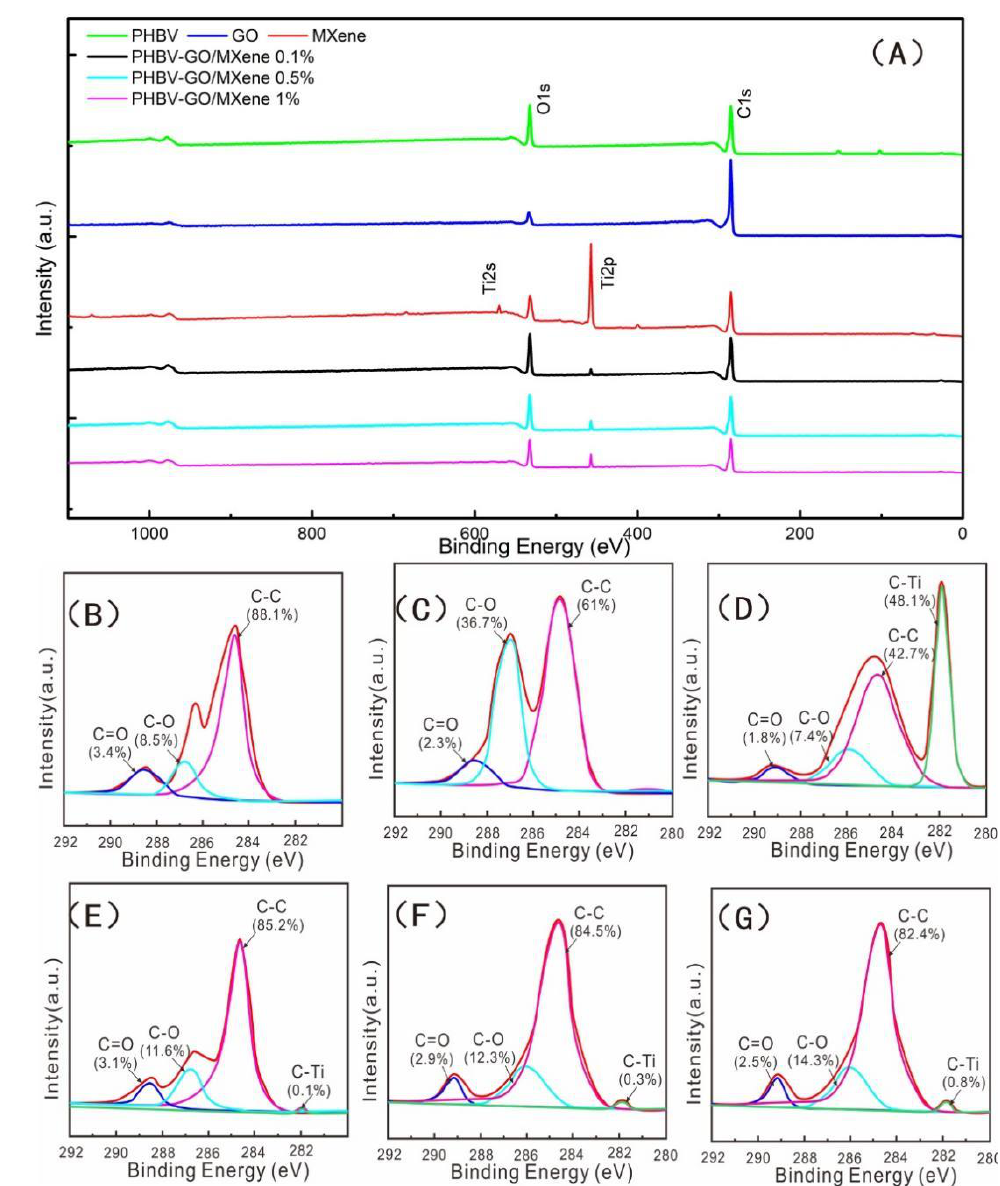
Figure 6. XPS spectrum ( A ) of PHBV, GO, MXene, PHBV—GO/MXene 0.1%, PHBV—GO/MXene 0.5%, and PHBV—GO/MXene 1% composite membranes. C1s XPS spectra of PHBV ( B ), GO ( C ), MXene ( D ), PHBV—GO/MXene 0.1% ( E ), PHBV—GO/MXene 0.5% ( F ), and PHBV—GO/MXene 1% ( G ) composite